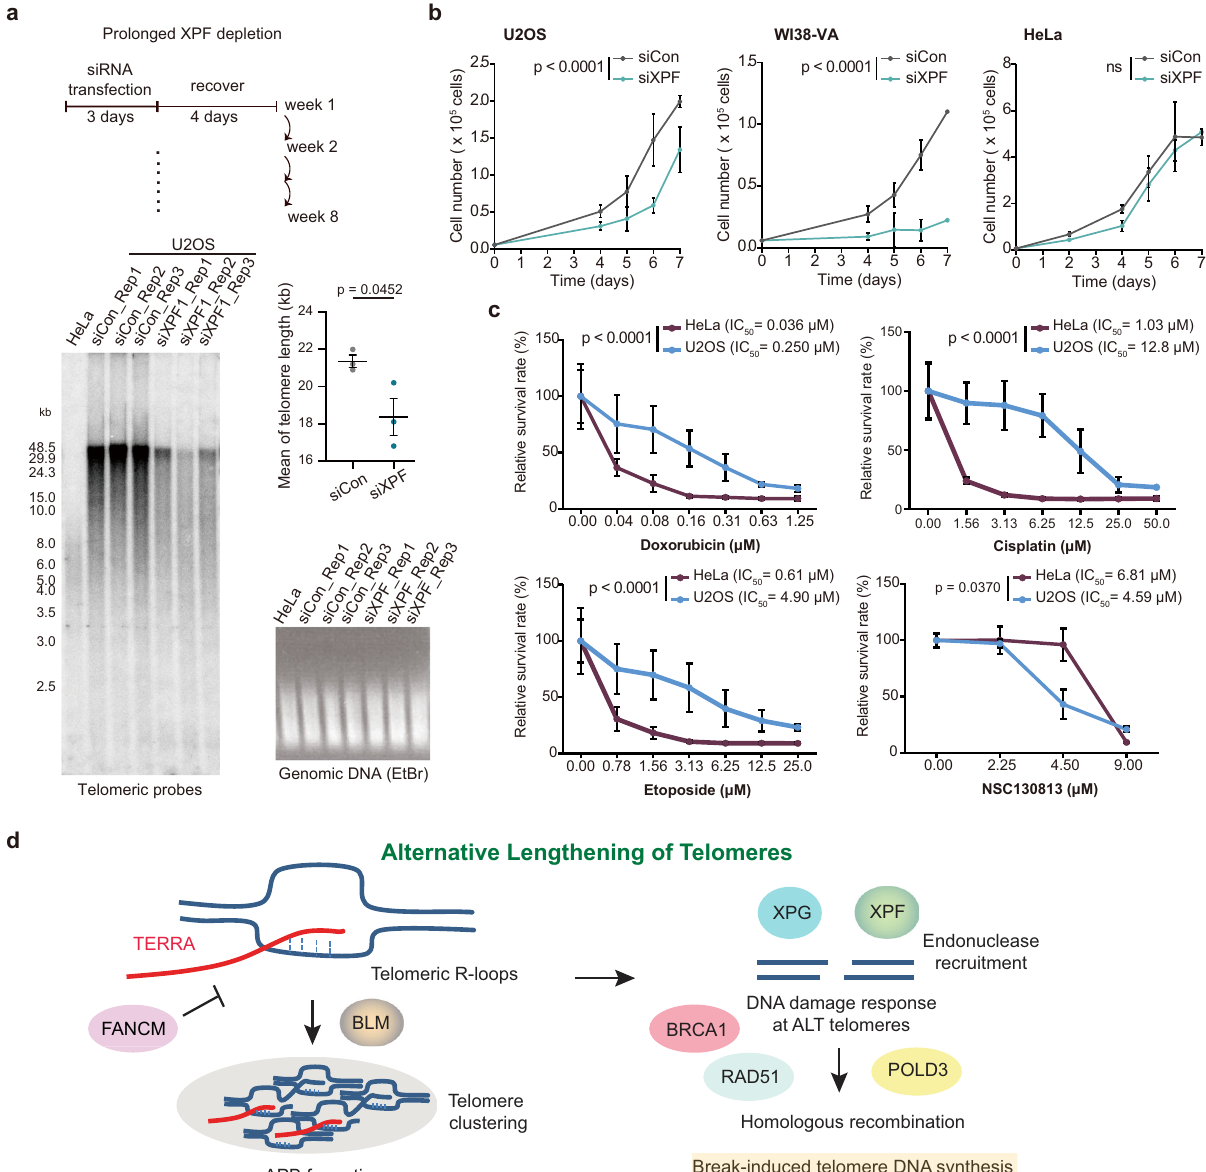
Fig. 7 | Inhibition of XPF suppresses cell proliferation in ALT cells. a Telomere lengthmeasuredbyTRFanalysisincellsafterprolongedXPF-depletionfor8weeks inU2OScells.ThesameamountofDNAasTRFassaywasloadedintheEtBrgel.The mean of telomere length was quanti fi ed (top-right) from three independent knockdownexperiments. P -values bytwo-tailed Student ’ s t -test. Bars, mean±SEM. b Cell proliferation assay after XPF knockdown in U2OS, HeLa, and WI38-VA cells. Bars,mean±SD. P -valuesbytwo-wayANOVA.ns,nosigni fi cance.Representativeof four independent experiments. Other replicates show similar trends and are